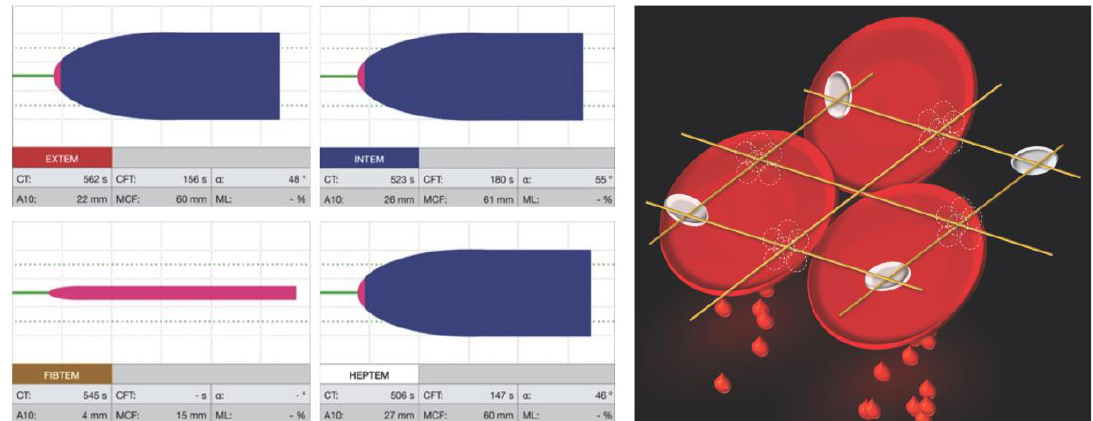
Figure 4. Coagulation factor deficiency: left, displayed by a four channel ROTEM ® report (EXTEM, INTEM, FIBTEM and APTEM); right, by Visual Clot visualization technology.